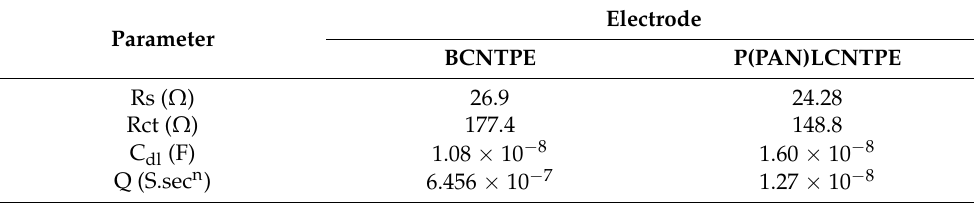
Figure 1. FE-SEM image of ( a ) BCNTPE and ( b ) P(PAN)LCNTPE. EDX image of ( c ) BCNTPE and ( d ) P(PAN)LCNTPE. Table 1. EIS results for BCNTPE and